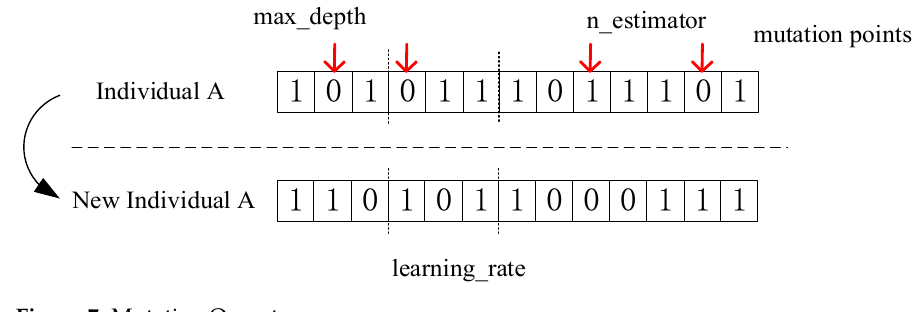
Figure 6. Crossover Operator.